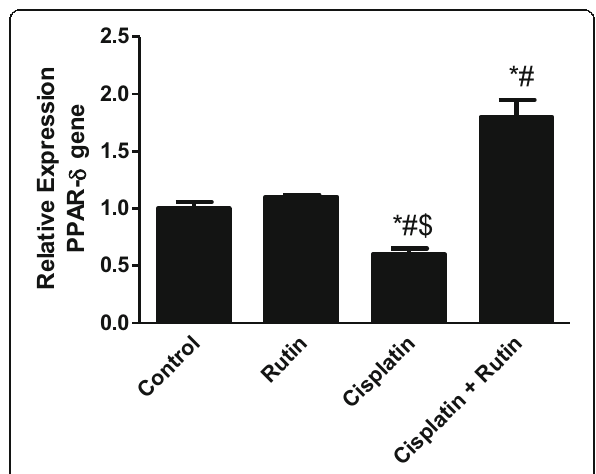
Fig. 4 The Effect of Cisplatin, rutin, and their combination on the expression levels of PPAR- δ in rat brain. Data were presented as mean ± SEM ( n = 10). *, # and $ indicate significant change from control, rutin and CP+ rutin, respectively, at P < 0.05 using ANOVA followed by Tukey – Kramer as a post ANOVA